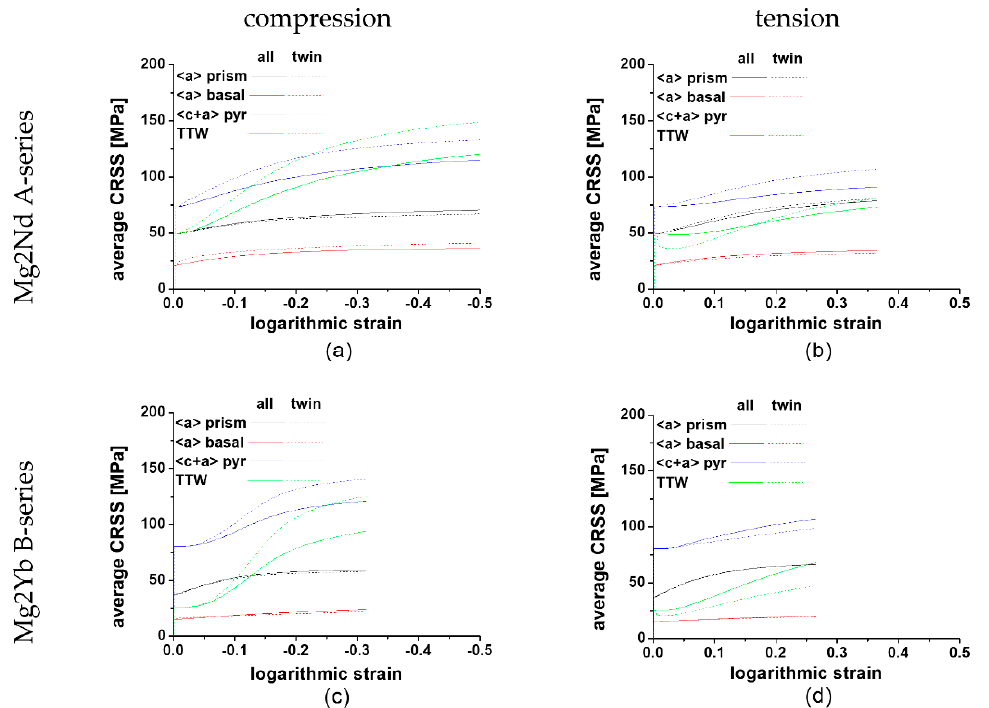
Figure 7. Critical resolved shear stresses (CRSS) of the different deformation systems as a function of strain of the Mg2Nd A-series during ( a ) compression and ( b ) tensile tests and the Mg2Yb B-series during ( c ) compression and ( d ) tensile tests.